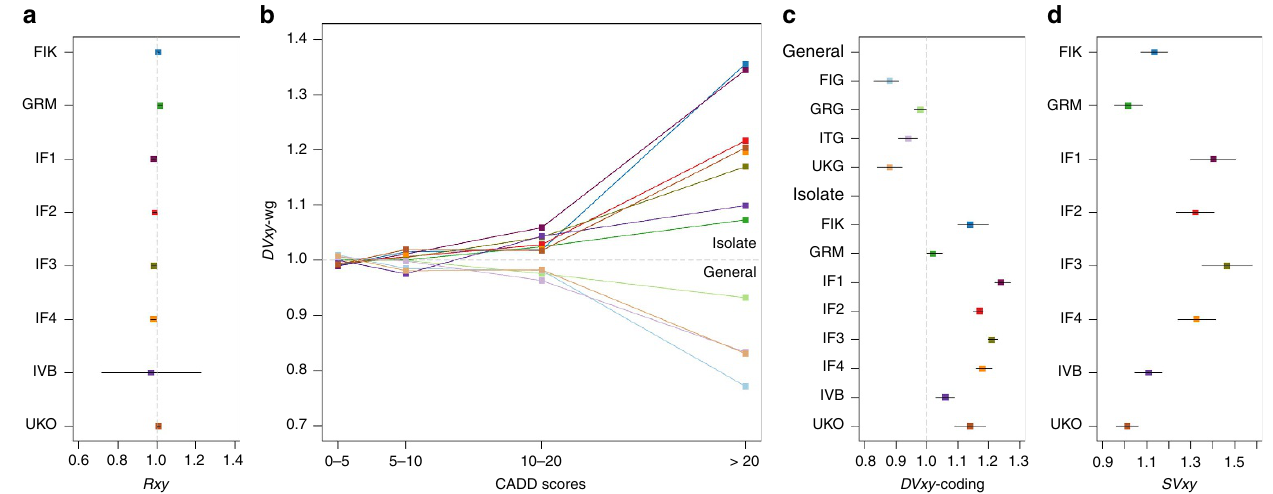
Figure 3 | Purifying selection in the isolates and general populations. ( a ) Rxy -missense statistic in each isolate, showing no evidence for increased genetic load in the isolates. The mean and s.d. for each Rxy value from 100 bootstraps are shown. ( b ) DVxy-wg ( DVxy -whole genome) statistic in isolates and general populations, stratified by CADD score, showing enrichment of highly functional low-frequency variants. ( c ) DVxy-coding statistic in isolates and general populations, showing enrichment of low-frequency missense variants in isolates. ( d ) SVxy -missense statistic in each isolate, showing relaxation of purifying selection in isolates in singletons. The s.e.’s for both DVxy and SVxy were calculated by randomly sampling data from 20 chromosomes 100 times. All of these analyses are based on the minimum-sample-size data set (36 individuals from each